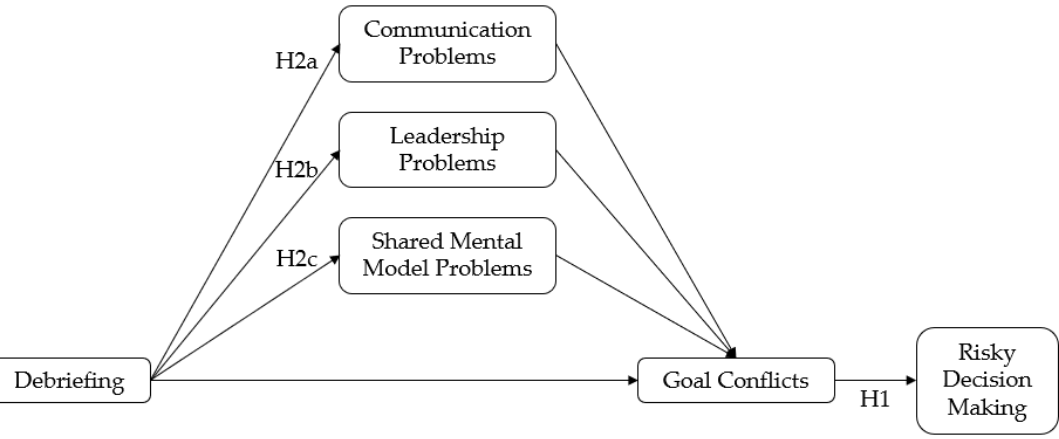
Figure 1. Overview of the theorized model.